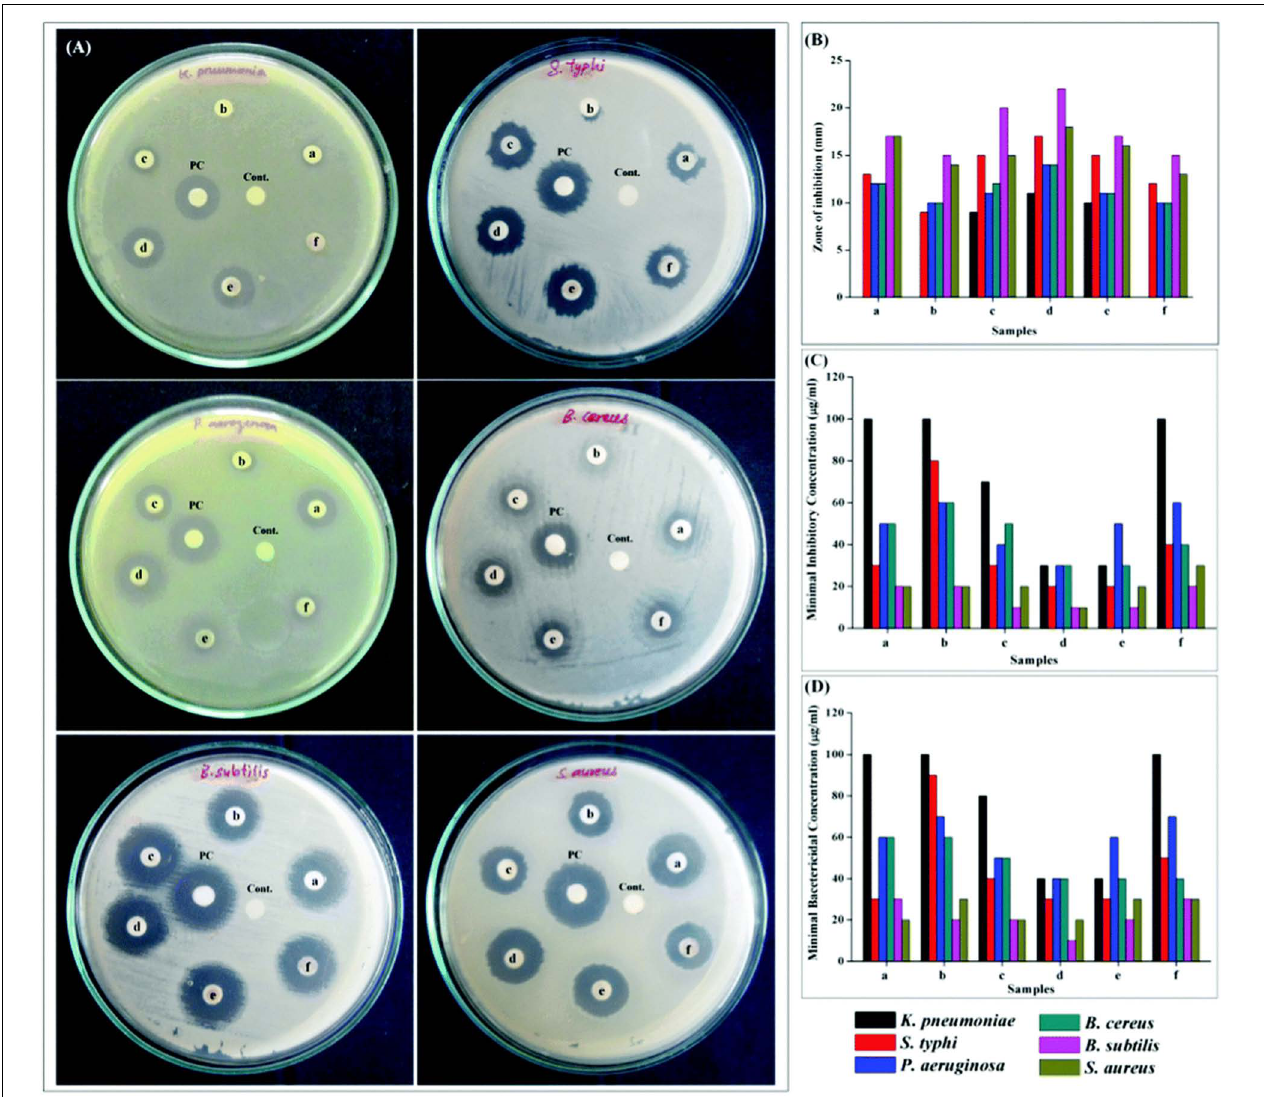
FIGURE 4 | Antibacterial activity using (A) disk diffusion assay for NiO and 1, 3, 5, 7, and 9 wt.% Ce-doped NiO (samples a–f), PC (positive control), and C (negative control). (B) Zone of inhibition, (C) MIC, and (D) MBC analyses. Reprinted with permission from Muthukumaran et al. (2016), copyright 2016 Royal Society of